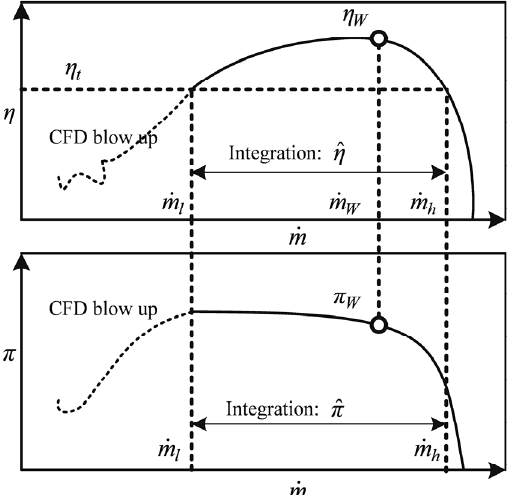
Figure 7. Typical operating characteristics calculated by CFD, with the definition of 7 selected performance variables.